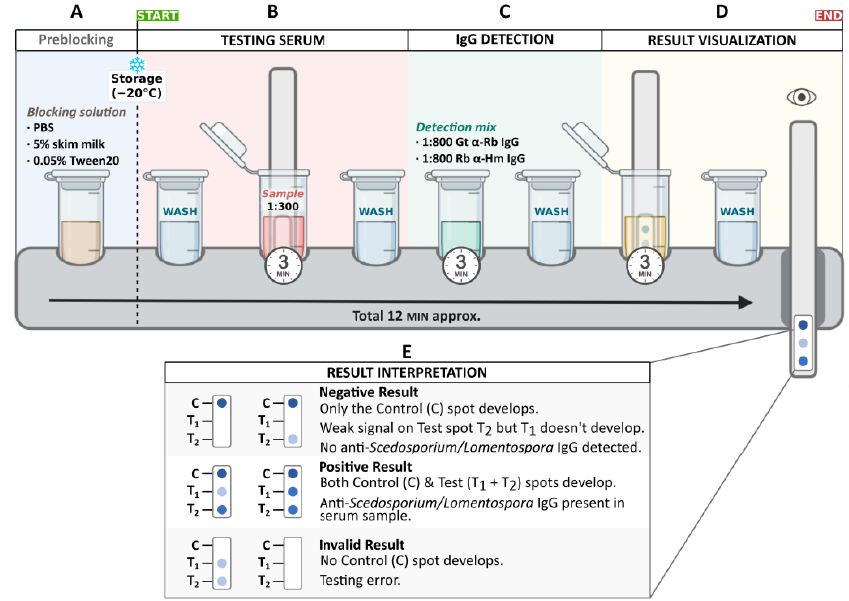
Figure 2. Testing procedure. Rapid immunoassay protocol starting from preblocked strips ( A ), 3 min incubation with testing serum sample ( B ), IgG detection with 3 min incubation with detection mix ( C ), soaking in TMB substrate for development of color ( D ) and visual interpretation of possible results ( E ).